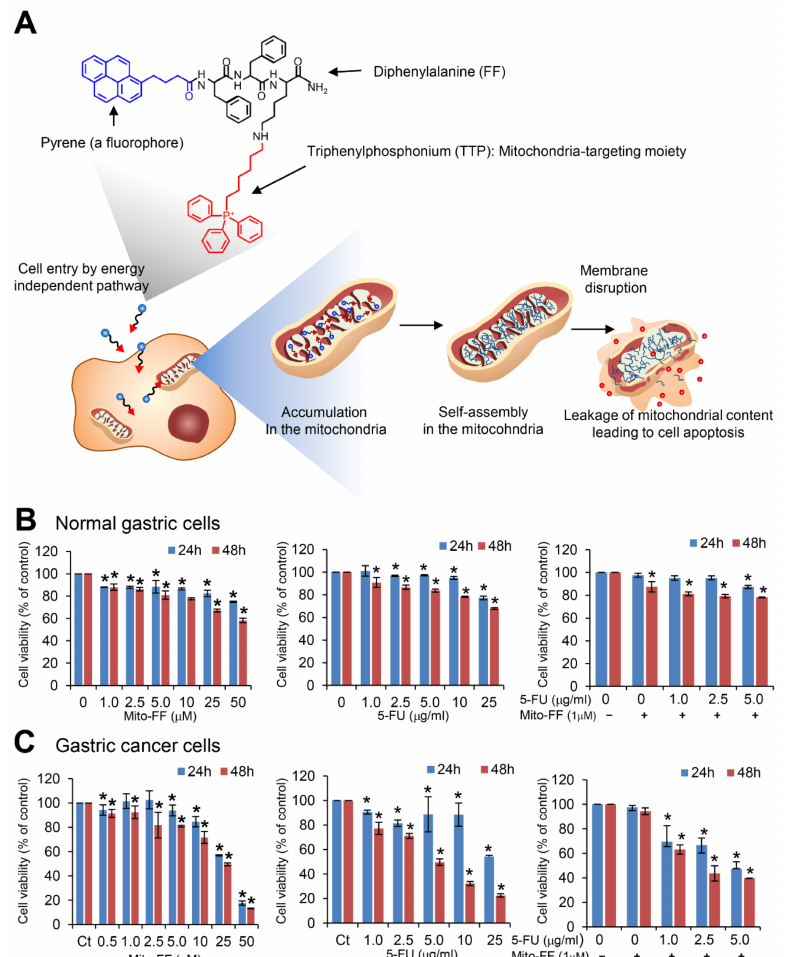
Figure 1. Action mechanism of triphenyl phosphonium (Mito-FF) and cell viability assay of 5-fluorouracil (5-FU) and Mito-FF, individually and in combination. ( A ) Intra-mitochondrial